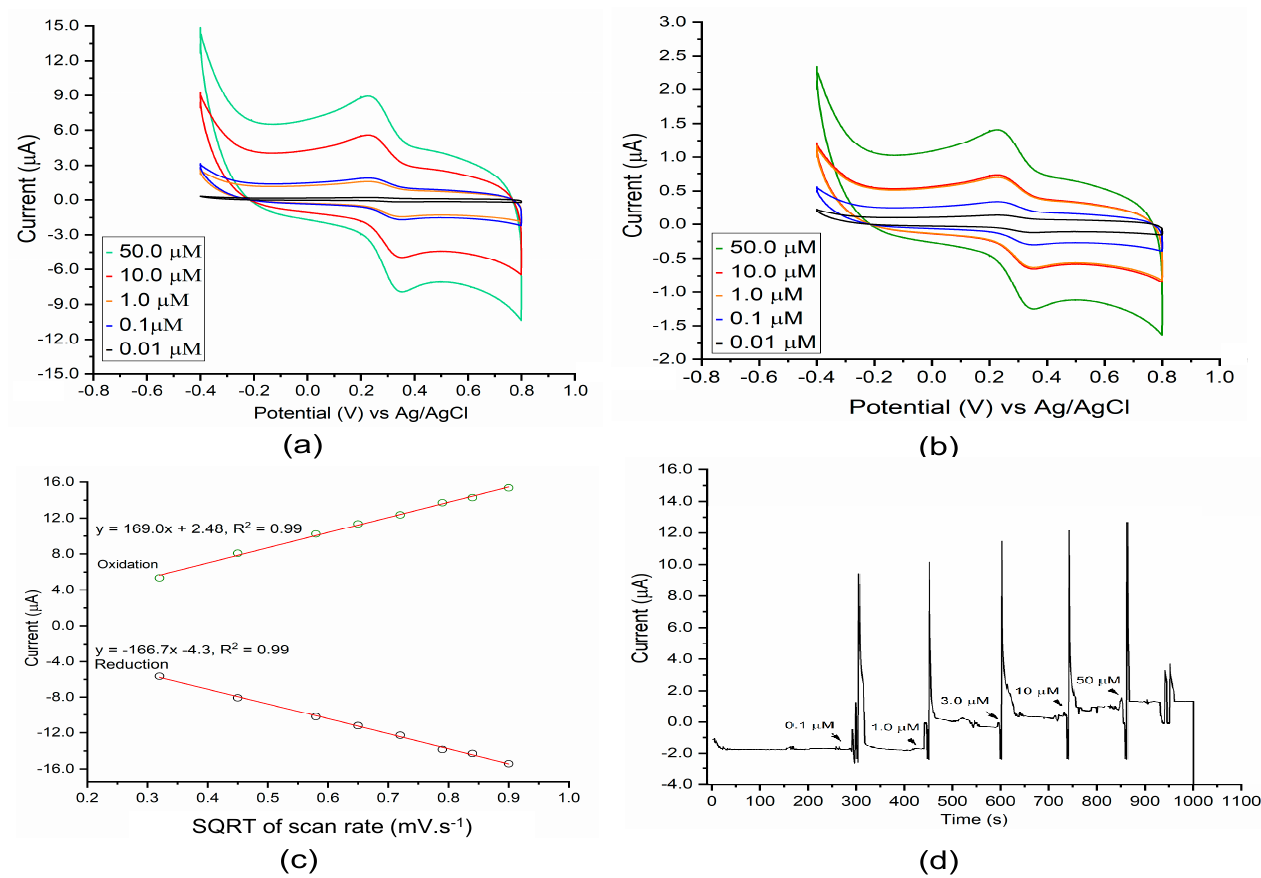
Figure 4. Cyclic voltammograms of ( a ) composited electrodes and ( b ) BSA-coated gold electrodes in 10 mM phosphate buffer supported with 0.1 M KCl. Scanning rate ( υ ): 0.2 mV/s. ( c ) Corresponding plots of cathodic and anodic peak currents versus the square root of potential scan rate from ( a ). ( d ) Amperometric responses of the composited electrode with successive addition of ATC solution under fluidic conditions in PBS pH 8.0 supported with 0.1 M KCl. Potential of 1.5 V vs. Ag/AgCl was applied on the composited sensor. The working solution was the phosphate buffer (10 mM, pH 8.0) mixed with 0.1 M KCl.